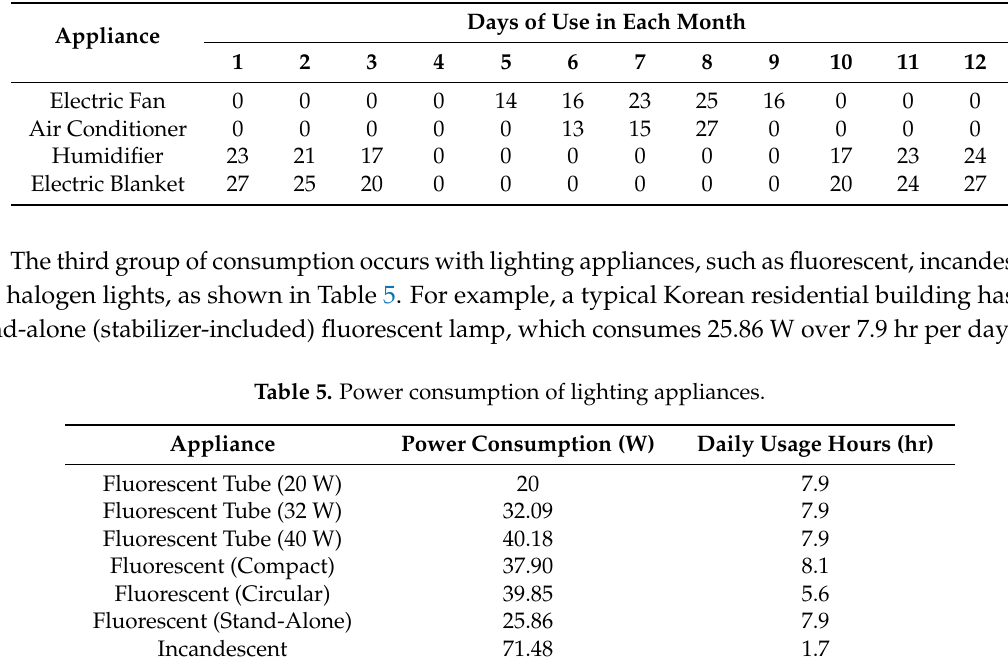
Table 4. Monthly usage of seasonal electrical appliances.